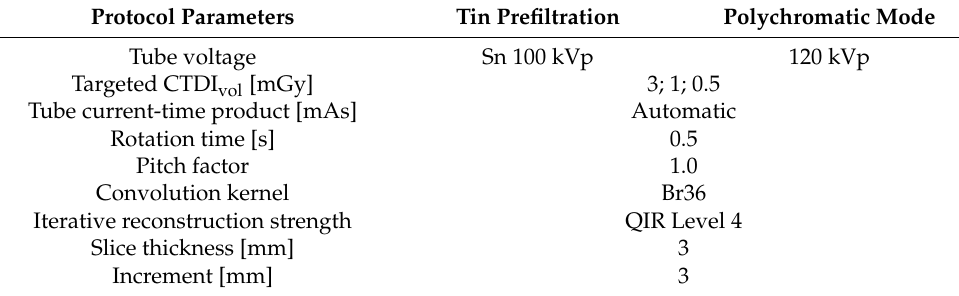
Table 1. Summarized technical details of the acquired protocols. Apart from dose settings all parameters were maintained